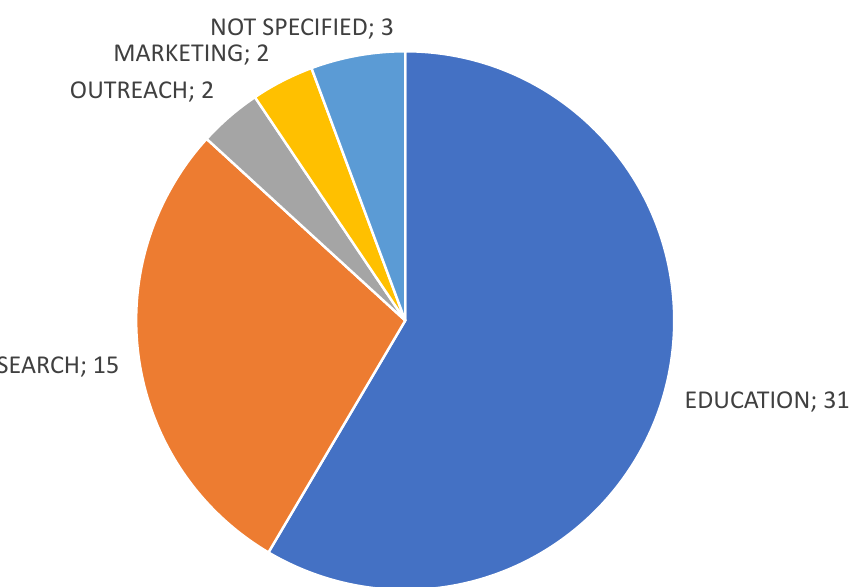
Figure 7. Number of times that the authors of the works analyzed declared directing the applications to education, research, outreach, and marketing.